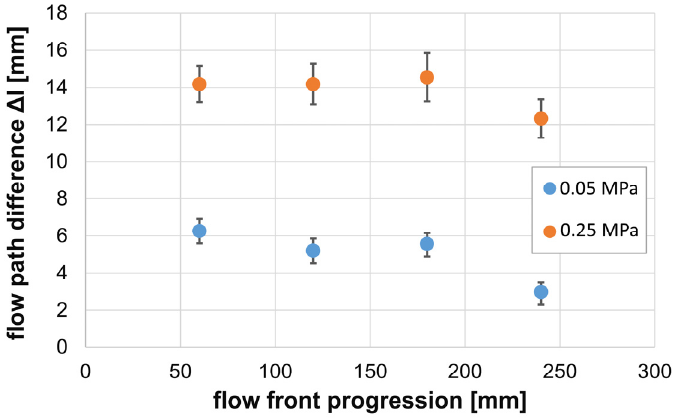
Figure 8. Flow path difference along the mold sections.